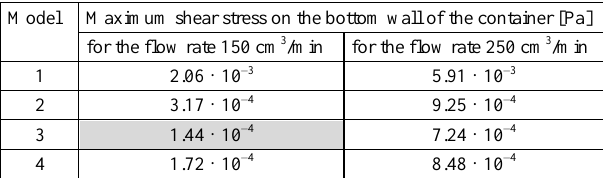
Fig. 11. Antibacterial filters are screwed to the external ends of the aspiration tubing via a specially selected